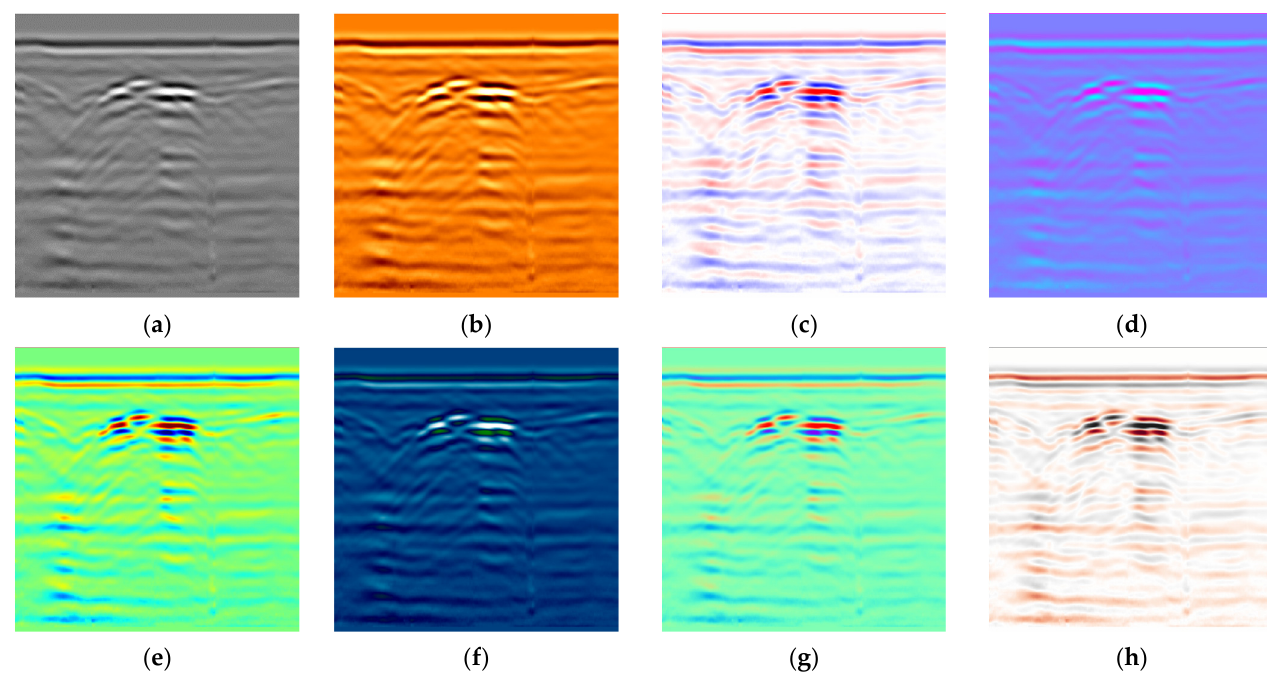
Figure 5. ( a ) The original GPR image at gray mapping rules; ( b – h ) are the GPR image at afmhot, bwr, cool, jet, ocean, rainbow, and RdGy mapping rules, respectively.